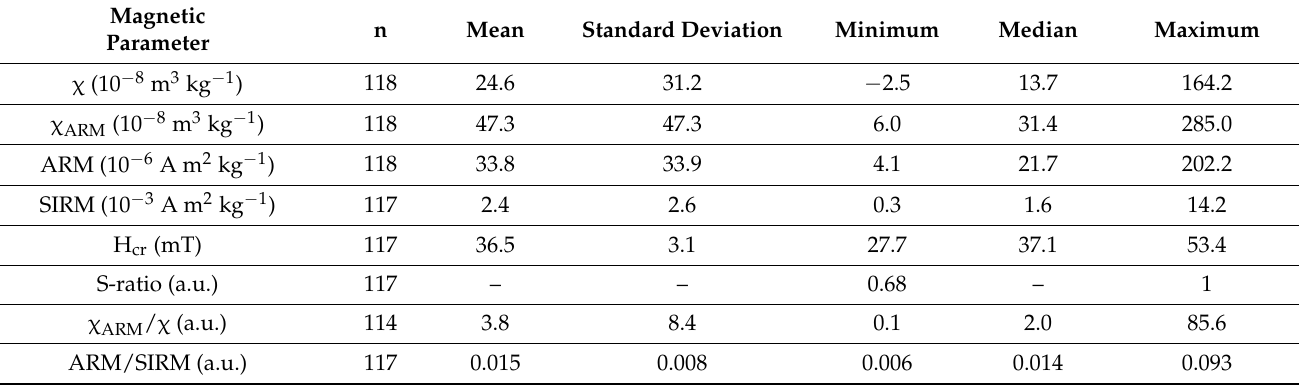
Table 1. Descriptive statistics of magnetic parameters for transplanted Tillandsia spp. over periods P1, P2 and